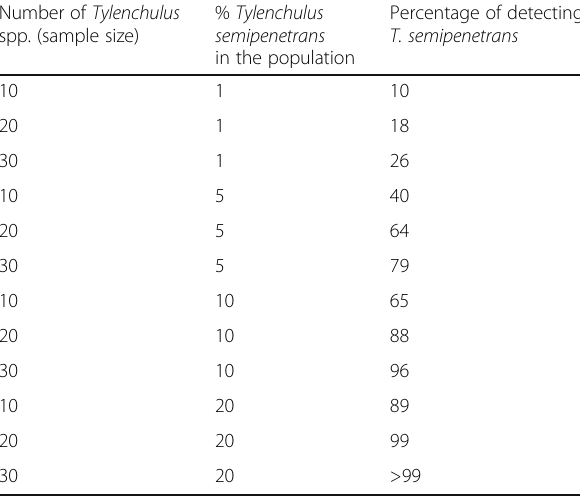
Table 3 Effect of sample size on the detection of Tylenchulus semipenetrans in a mixture with both T . palustris and T . graminis (Abd-Elgawad and McSorley 2009)